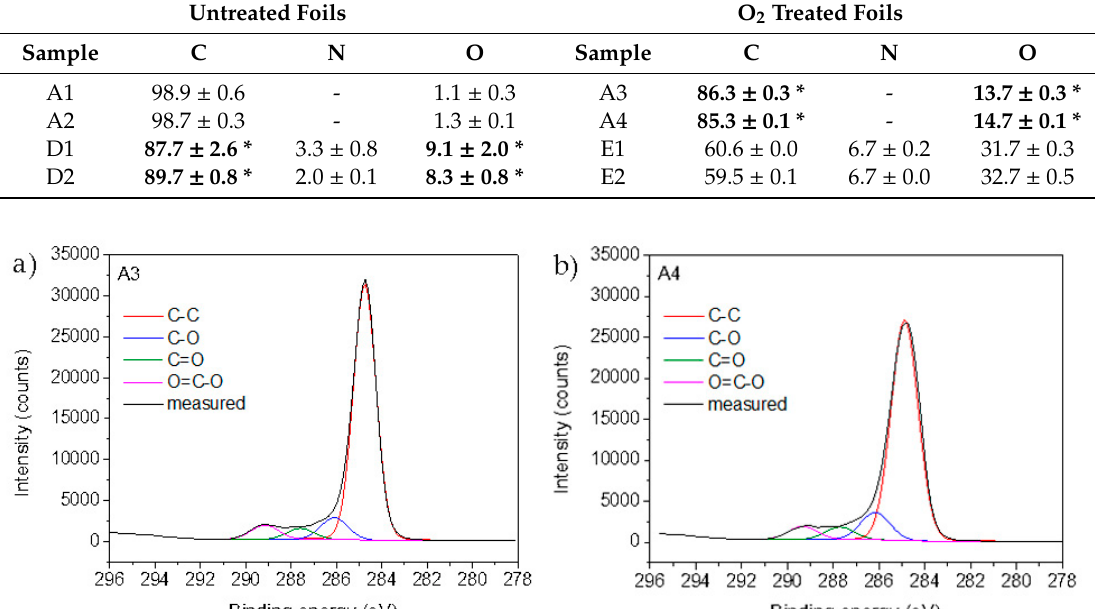
Table 6. Surface chemical composition (at.%) of the reference foils and plasma-treated foils with the two-layer coating (at.%). Statistical significance is defined as * p < 0.05 compared to control sample (ANOVA test). Untreated Foils O 2 Treated Foils